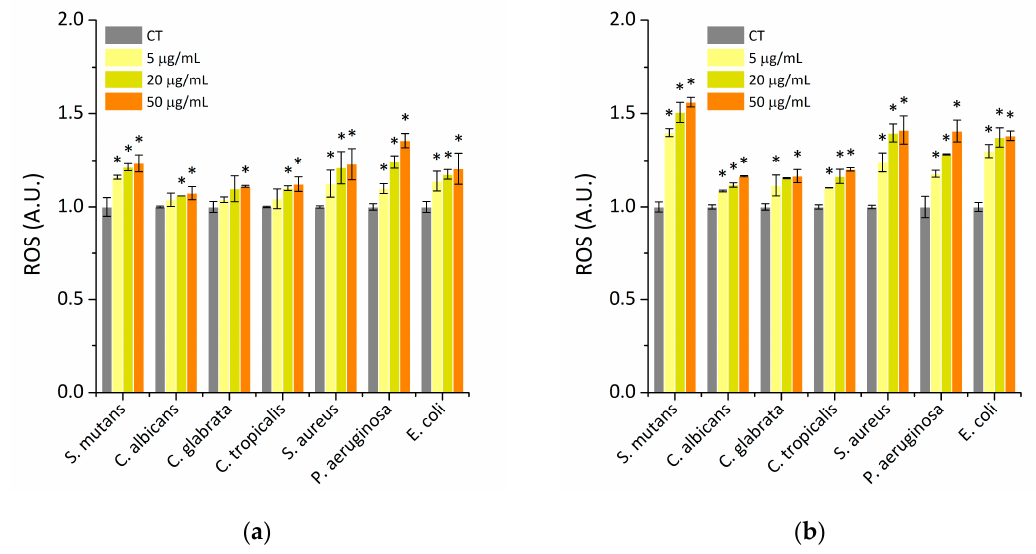
Figure 6. Results of reactive oxygen species (ROS) generation: ( a ) MNP@Au; ( b ) MNP@NH 2 . Statistical significance for the tested preparations compared to control was marked by (*) p ≤ 0.05. Results from three measurements ±SD.